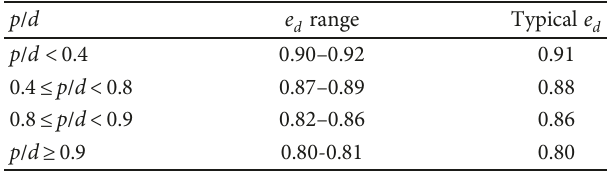
Table 1: Estimated e ff ective propeller